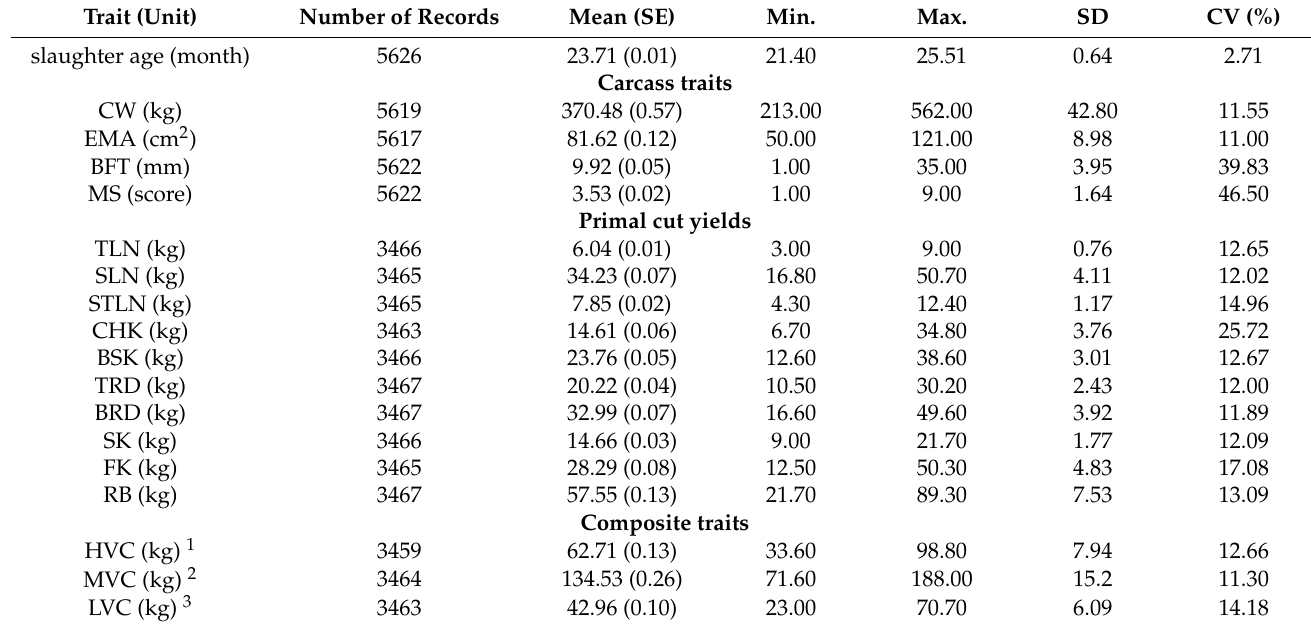
Table 1. Summary statistics for carcass traits, primal cut yields, and composite traits in Hanwoo cattle. Trait (Unit) Number of Records Mean (SE) Min. slaughter age (month) 5626